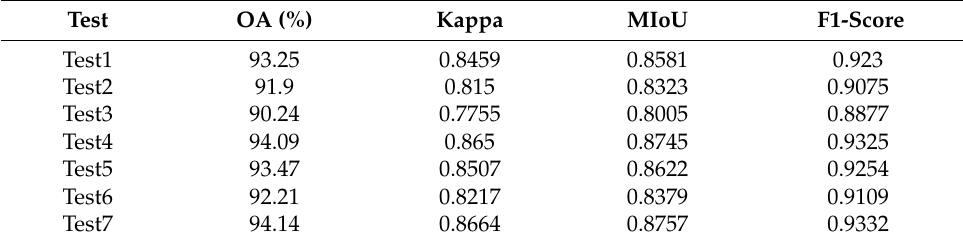
Table 7. Impervious surface extraction accuracies of UNet with different feature inputs.